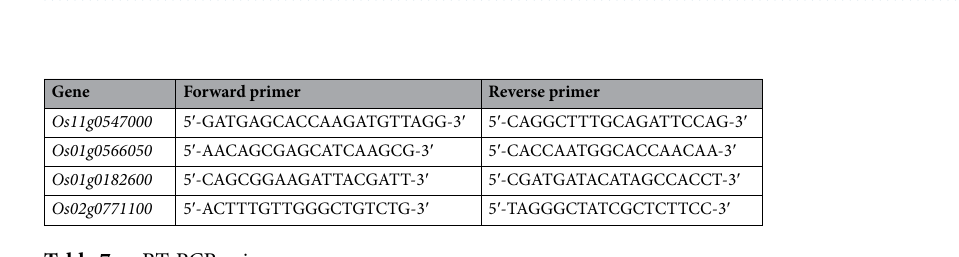
Table 7. qRT-PCR primers.